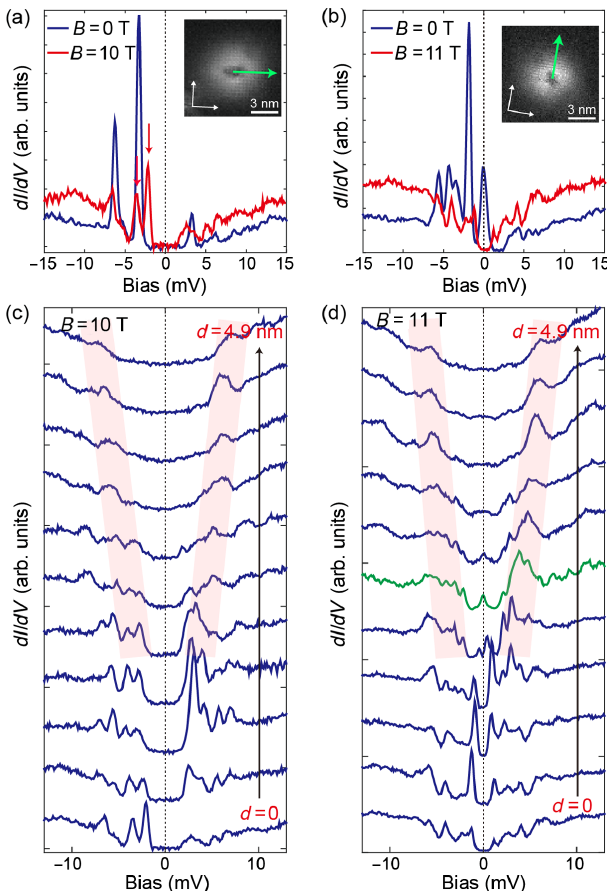
FIG. 5. Bound states in the impurity pinned vortex cores. (a,b) dI=dV spectra measured on two dimerlike defects at B ¼ 0 T and B ¼ 10 ð 11 Þ T ( V ¼ − 17 mV, I ¼ 60 pA). Insets in panels (a) b and (b): ZBC maps of the pinned vortex. (c,d) dI=dV spectra measured along the arrows in the inset image,